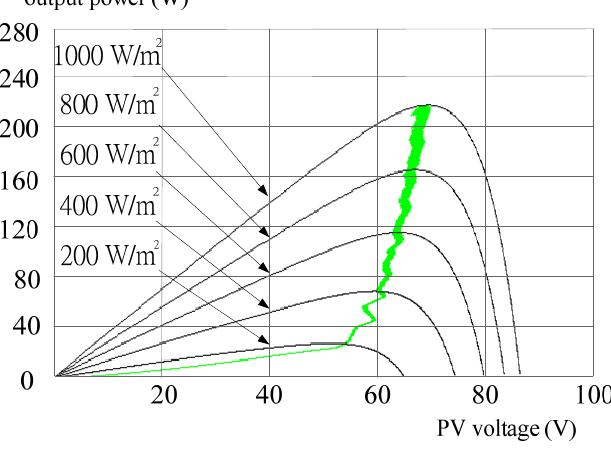
Figure 10. The MPPT trajectory by the POM under fixed temperature.